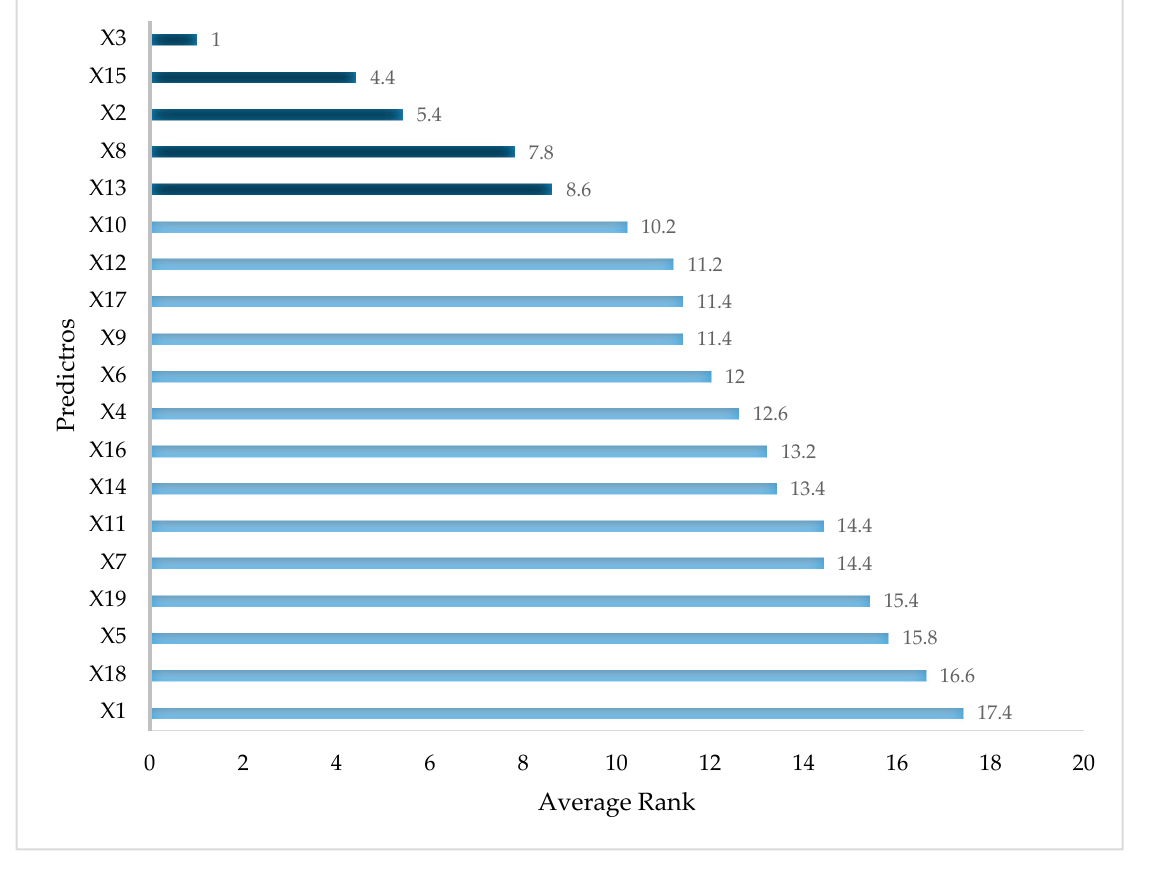
Figure 2. Ranking of all predictors.